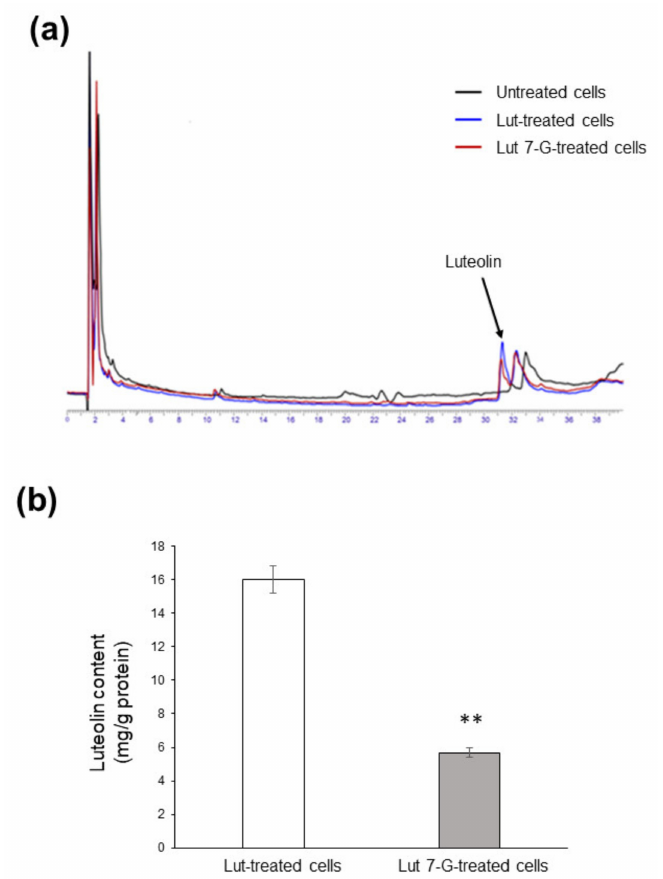
Figure 9. Uptake of luteolin and luteolin-7-O-glucoside by Caco2 cells. ( a ) Caco2 cells were left untreated (black line) or treated with 20 µ g/mL of either luteolin (Lut-treated cells; blue line) or luteolin-7-O-glucoside (Lut 7-G-treated cells; red line) for 24 h, before HPLC analysis. ( b ) Concentra- tion of luteolin inside cells as measured by HPLC. ** p < 0.01 vs. Lut-treated